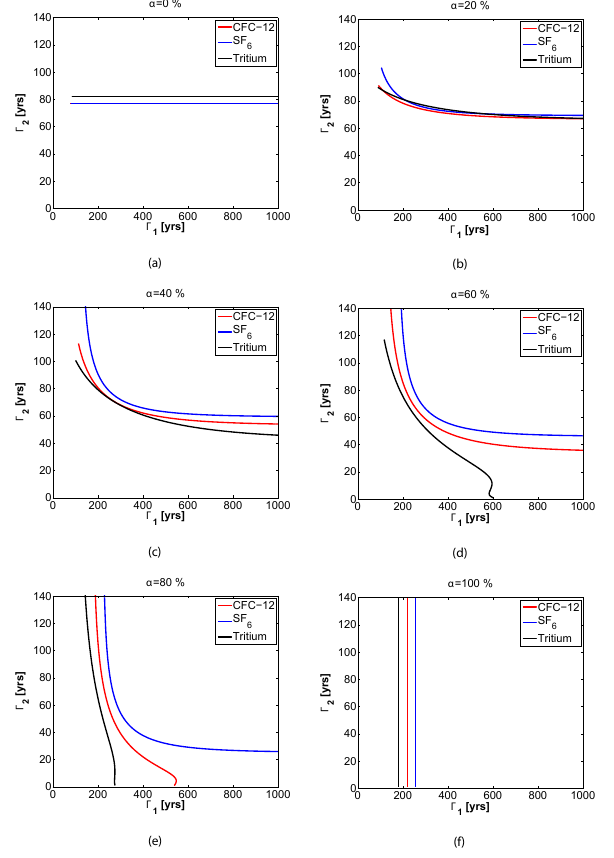
Figure 17. Example of a mean age calculation from three transient tracers (CFC-12, SF 6 and tritium) at station 290 at 1775m depth. The six panels are for different fractions of the older water mass ( α value). The 1/0 ratios are set to 0.6 for the younger water mass, and to 1.4 for the older water mass. Panel (a) shows the selected result, see text.